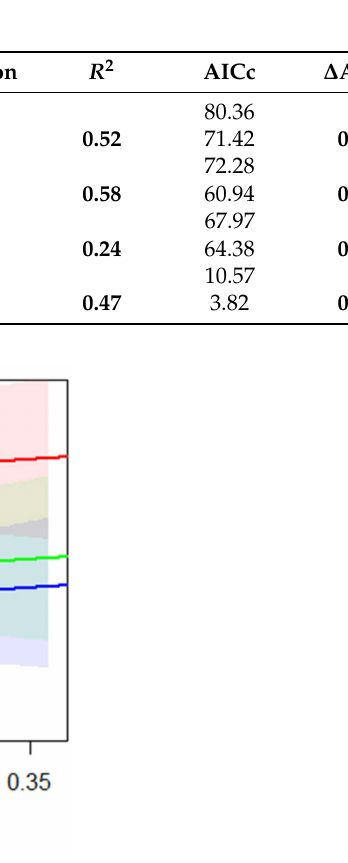
Figure 4. Relationship between ecosystem multifunctionality and functional richness per site (natural forest in red, restored forest in green and agroforestry system in blue). The shaded area shows 95% confidence